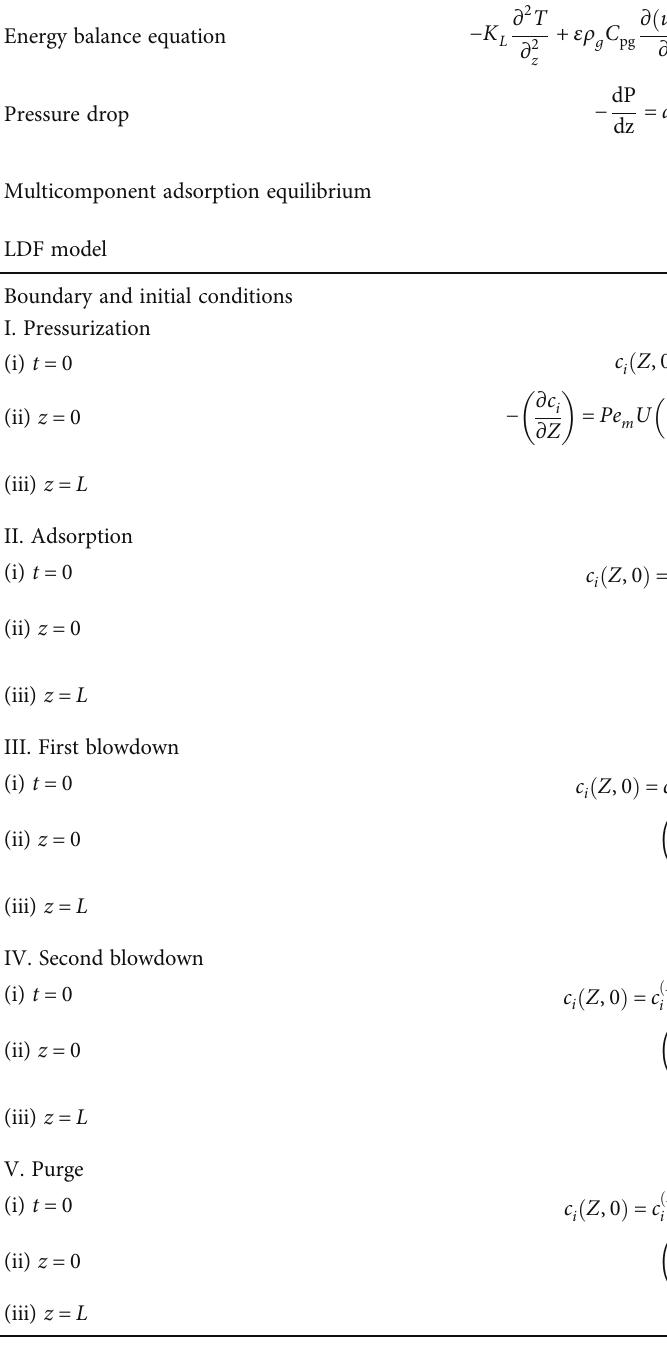
Table 17: Governing equations and simpli fi cations for production and puri fi cation of medical oxygen. Overall mass